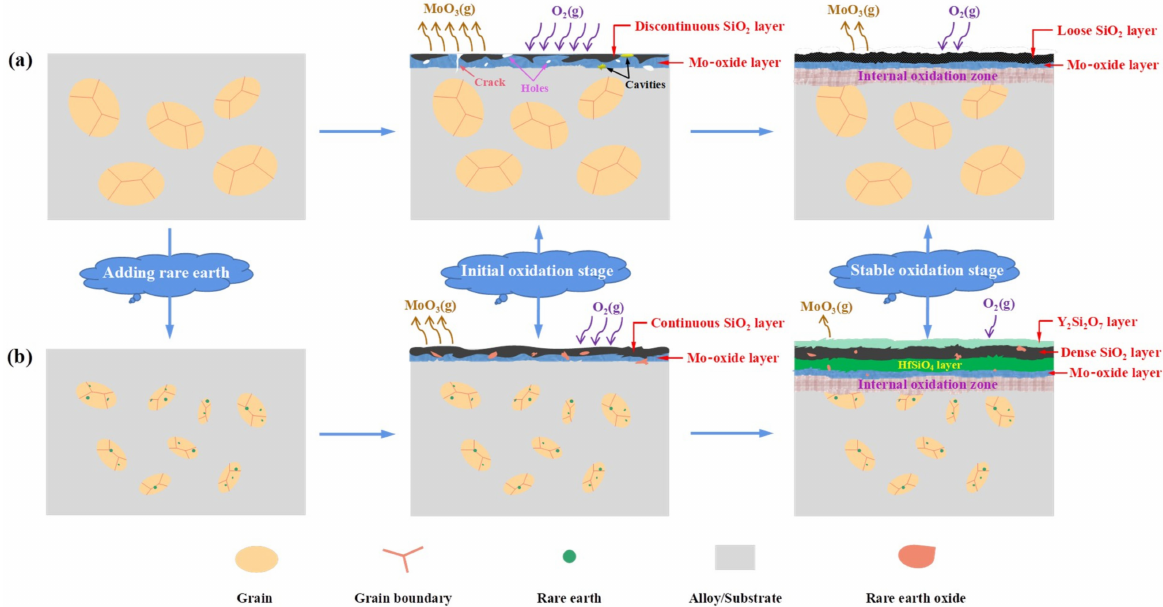
Figure 16. Schematic diagram of the oxidation process for Mo-Si-based alloy at medium-high temperature: ( a ) without rare earth elements, ( b ) doped with rare earth